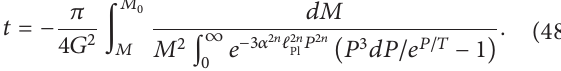
numerically the decay time as the function of the black hole mass and give the Hawking decay time and the GUP 0 -, GUP 1 -, and GUP 𝑛 -corrected decay times in Tables 1 and 2. Table 1 indicates that the decay time (the numerical